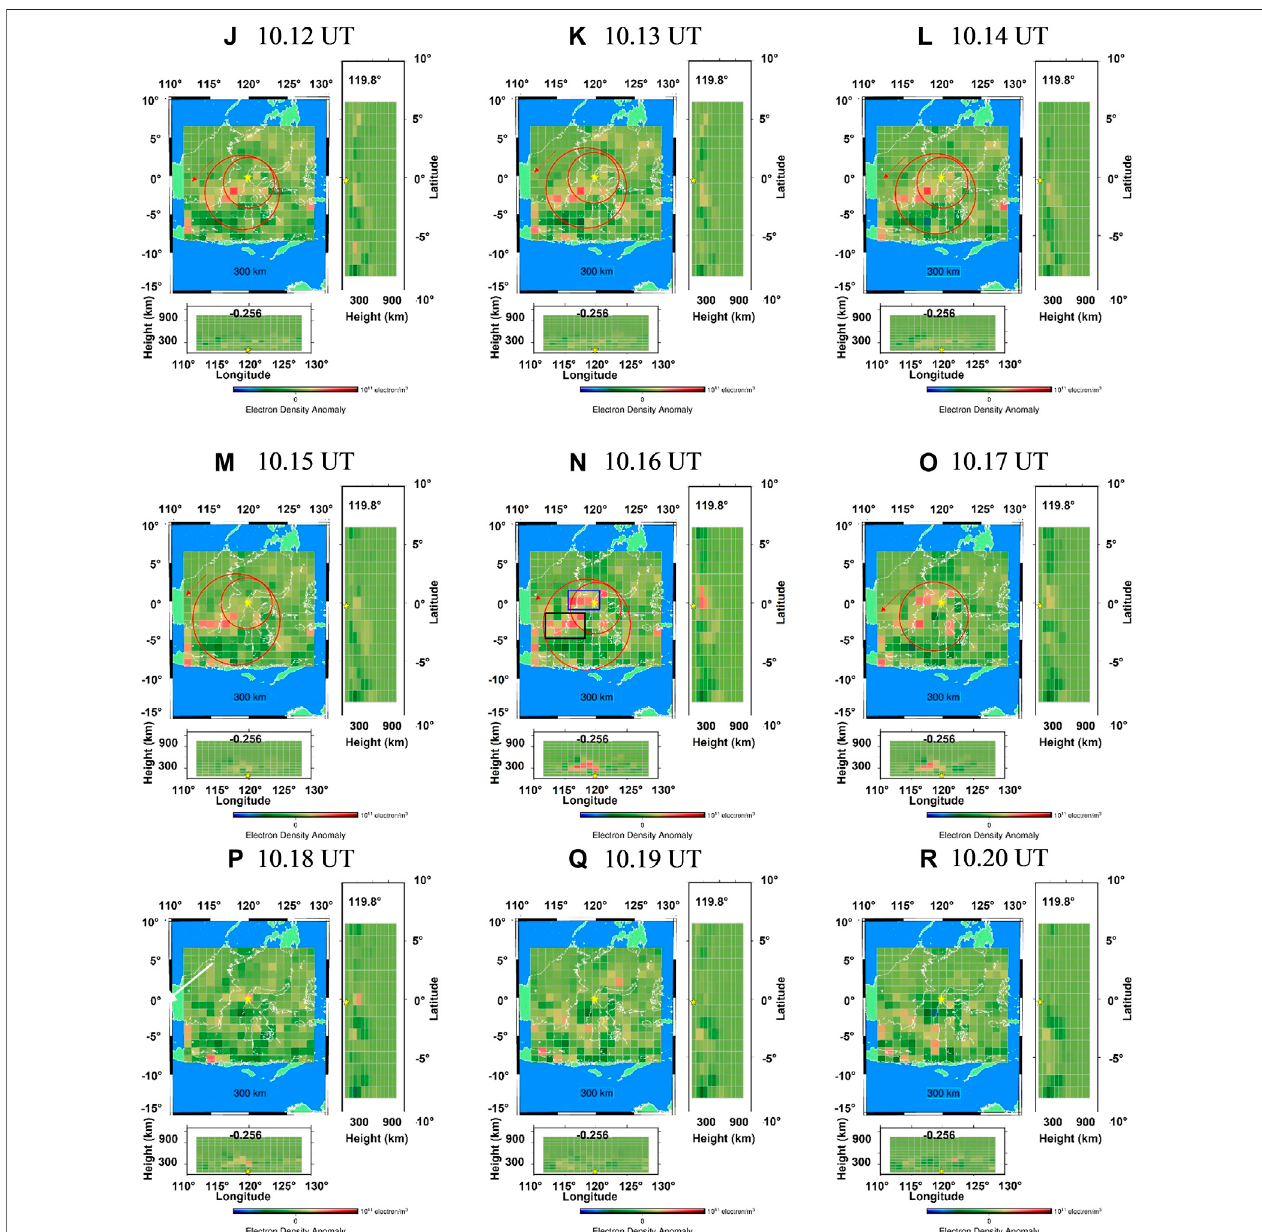
Figure 4 (bottom panel) shows the distribution of the anomalies recovered using the synthetic data, suggesting that the spatial structures can be well resolved, with the recovered amplitudes accounting for about two-thirds of the